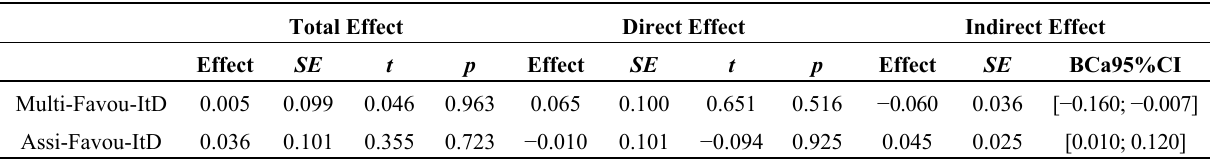
Table 4. Summary of total, direct and indirect